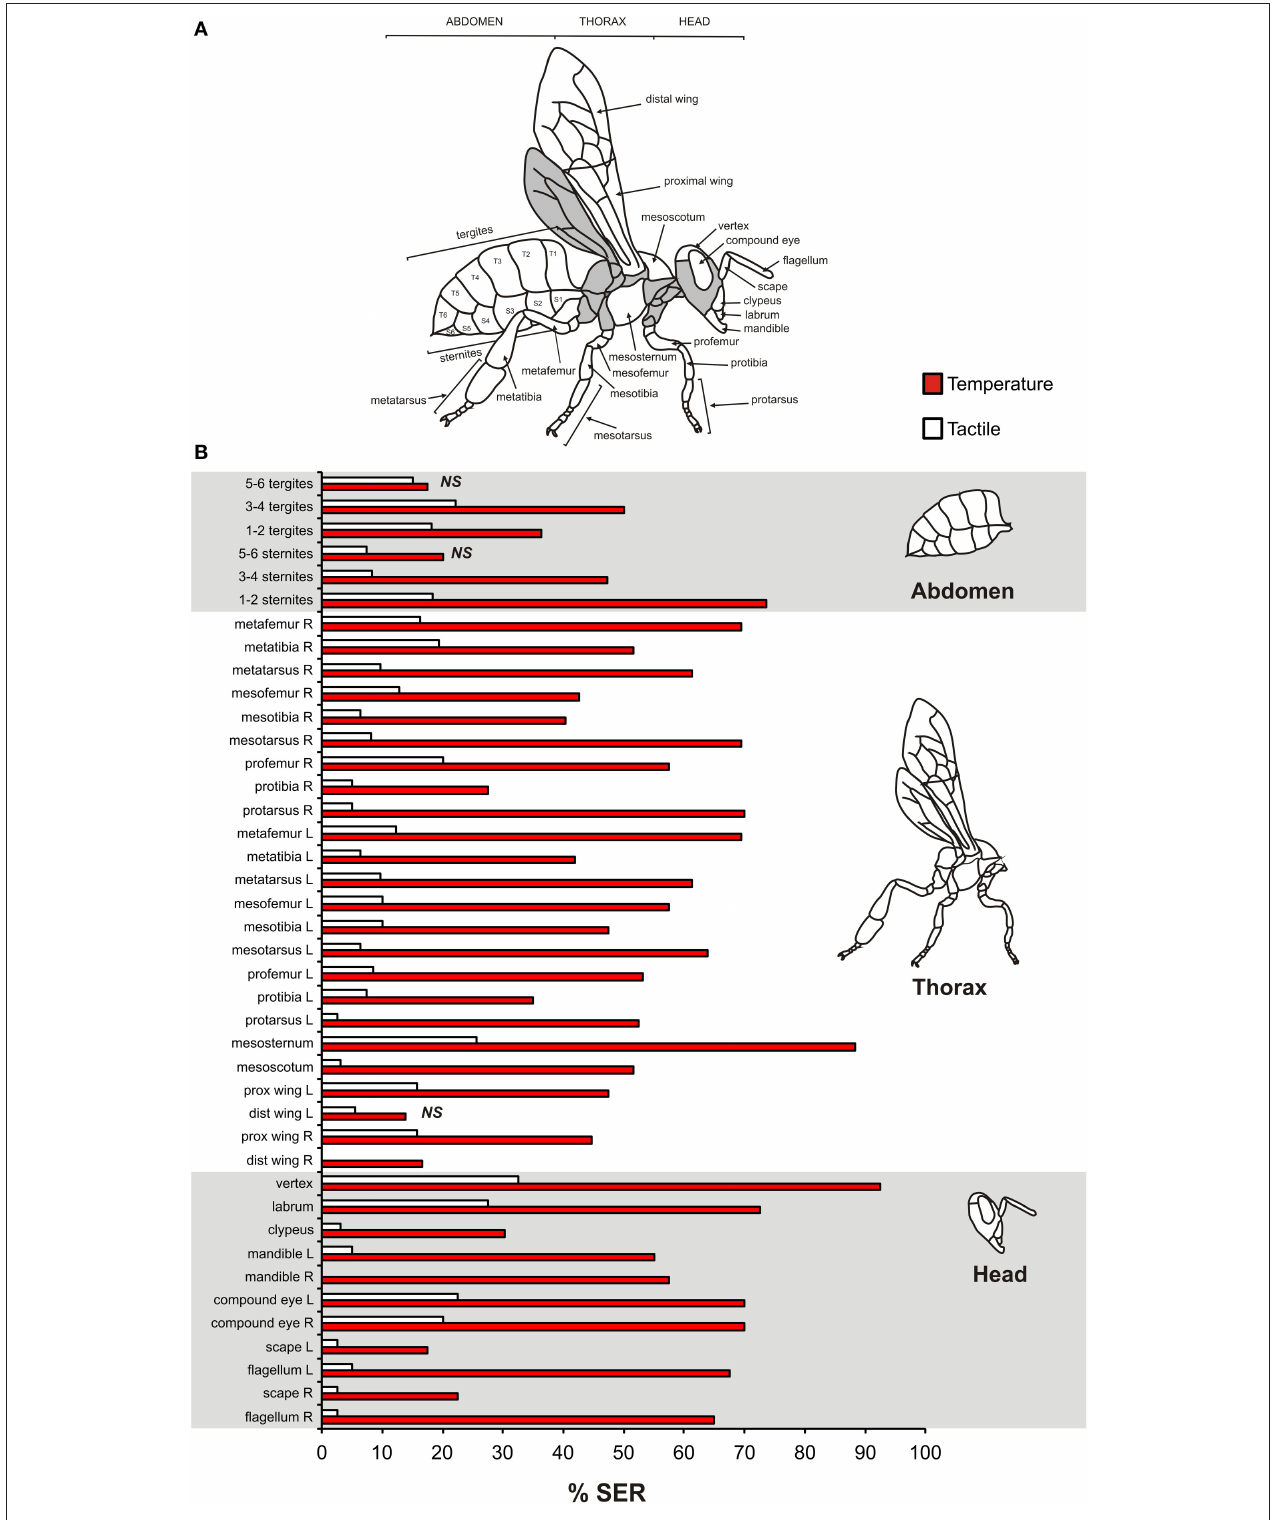
FIGURE 1 | Impact of thermal stimulation of 41 structures of the honeybee body on sting extension responses (SER). (A) Map of the bee body showing the names of the tested structures. Gray areas were not accessible in our holding setups and were thus not tested. (B) Percentage of SER observed for thermal stimulations on the 41 different body parts using a heated copper probe ( n = 555 , four structures tested per bee). As control, tactile stimulations with an unheated probe were given. Prox, proximal; dist, distal; L, Left; R, Right.